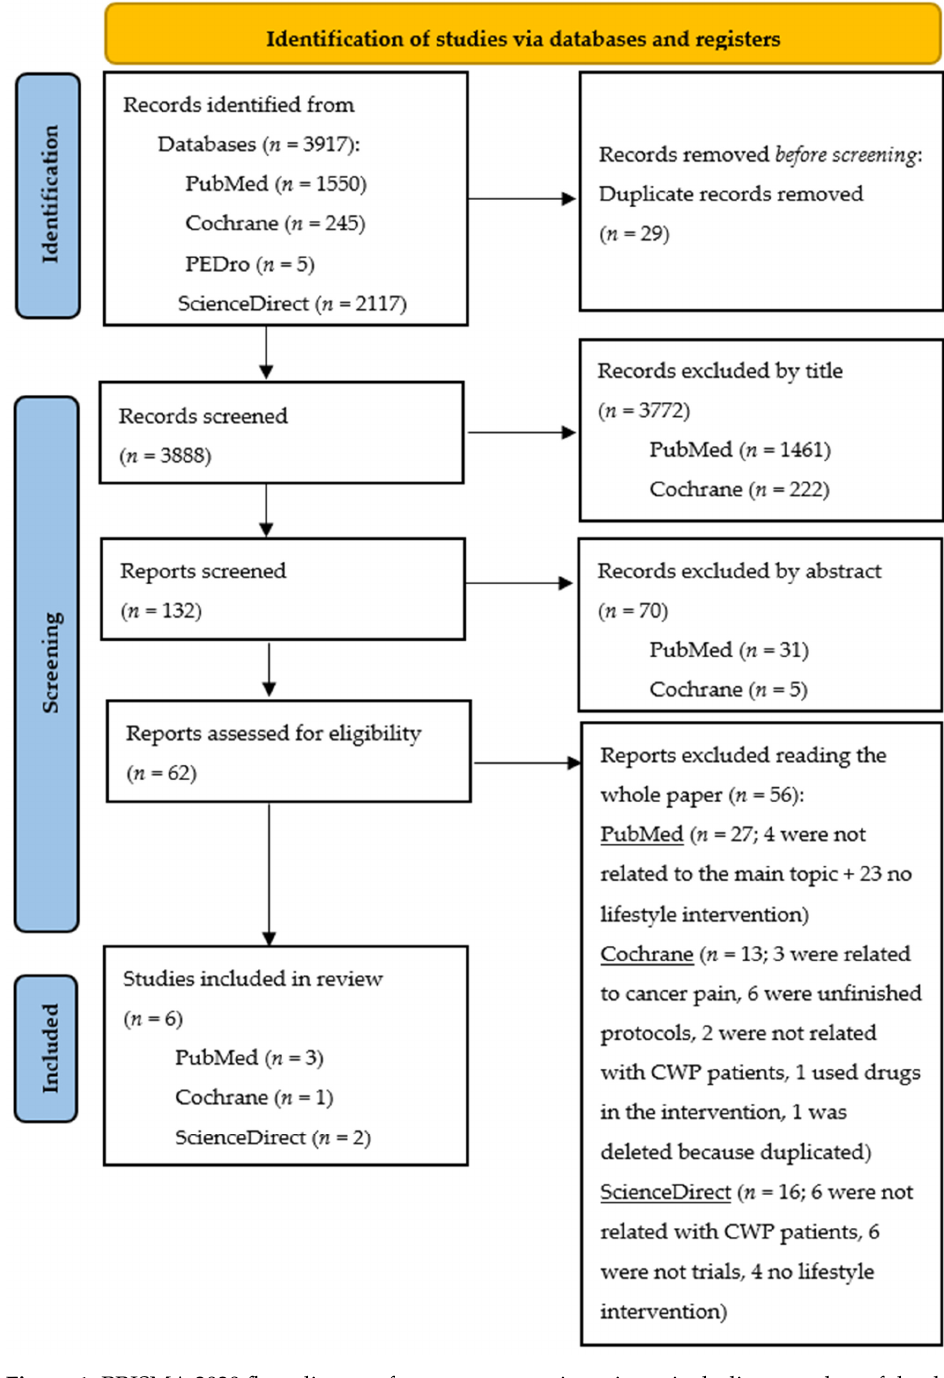
Figure 1. PRISMA 2020 flow diagram for new systematic reviews, including searches of databases and